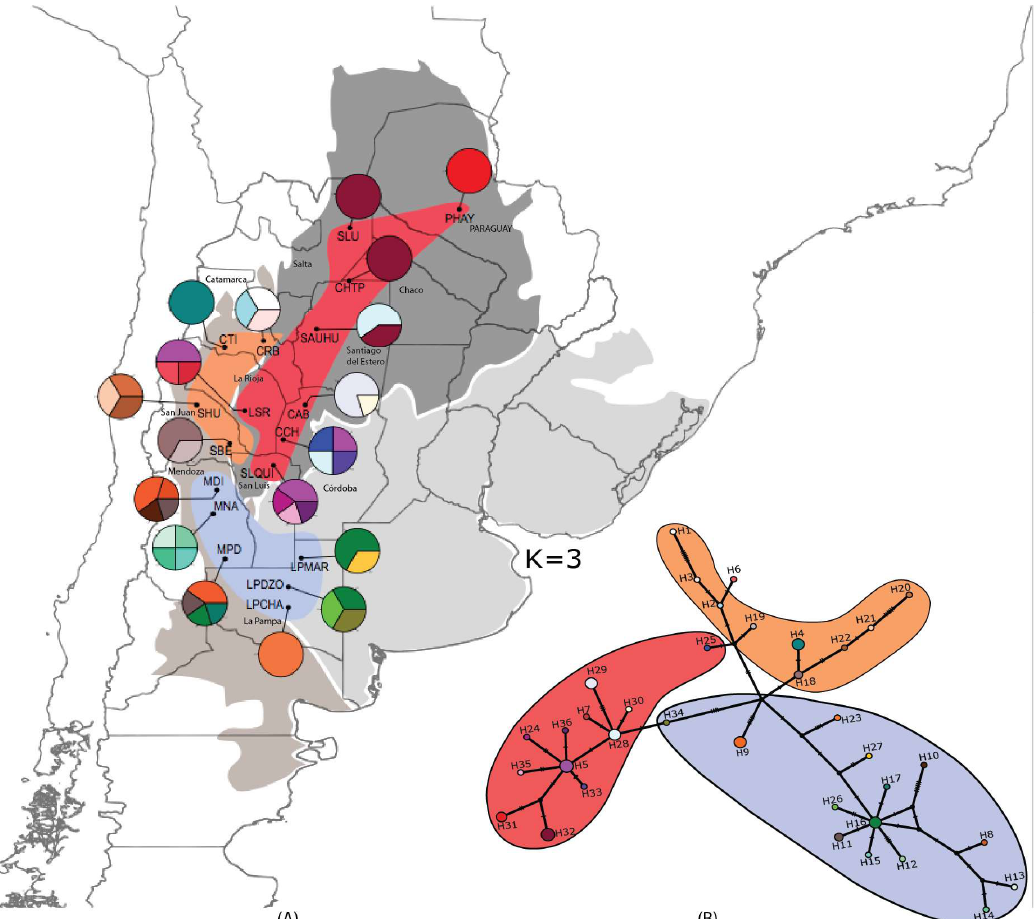
Figure 2. ( A ) Northwestern region of Argentina with all Hydnorobius hydnorae collecting localities. Details associated with locality codes can be found in Table 1. The larger shaded areas correspond to biogeographic provinces as in Morrone [27]. Pie charts indicate proportional presence of distinct Cytochrome B (Cyt-B) haplotypes in each locality. ( B ) Minimum spanning network showing all Cyt-B haplotypes for the 18 localities. Haplotype IDs are indicated by the circles and the size of the circles is proportional to the frequency of each haplotype. Dashes on the haplotype connections indicate the number of mutational steps between them. Sections of the network are colored according to the locality groups suggested by the SAMOVA analysis ( K = 3). Those same colors are then depicted on the map grouping localities in three areas: North (red), Central (orange) and South (blue).